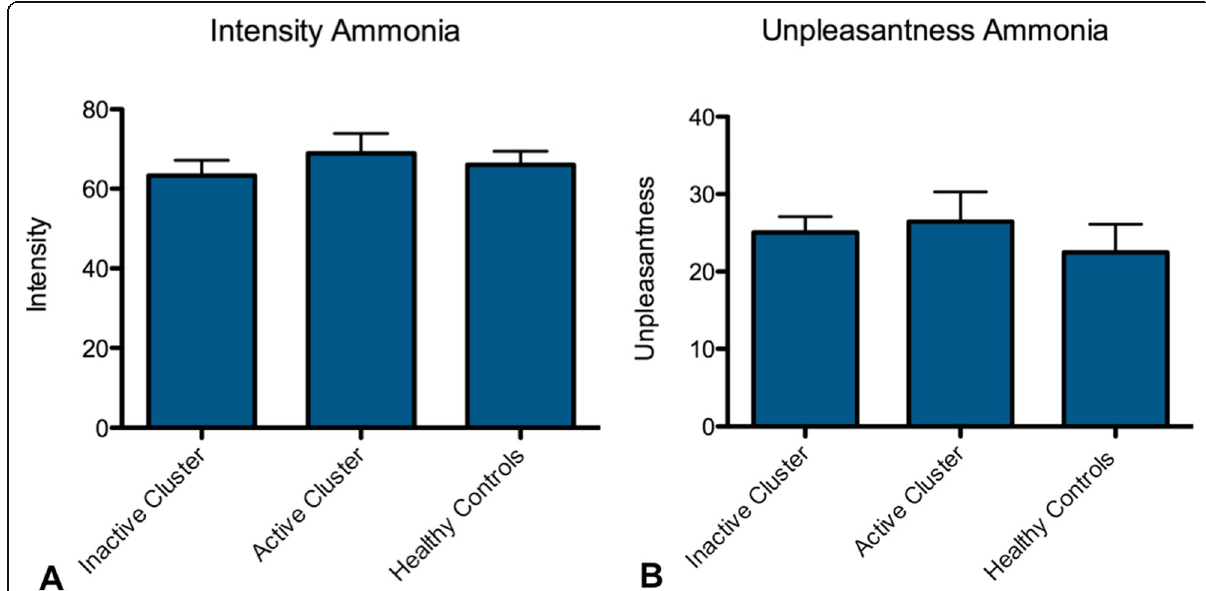
Fig. 1 Intensity and unpleasantness ratings of the ammonia stimulus among the three study groups. Bars depict the mean within each group. Error bars indicate standard error of mean. No significant differences were observed regarding intensity and unpleasantness ratings between the three study groups